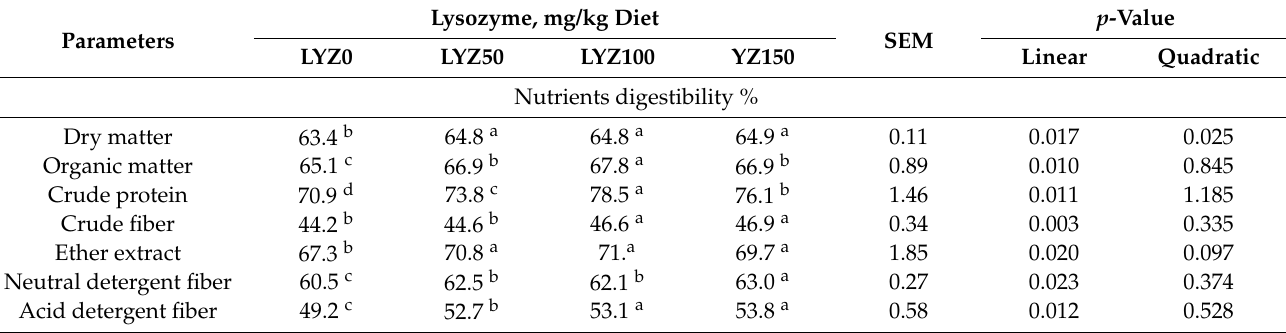
Table 3. Nutrients digestibility in growing rabbits fed diets supplemented with different levels of lysozyme. Digestibility trial performed from 60 to 72 days of age.